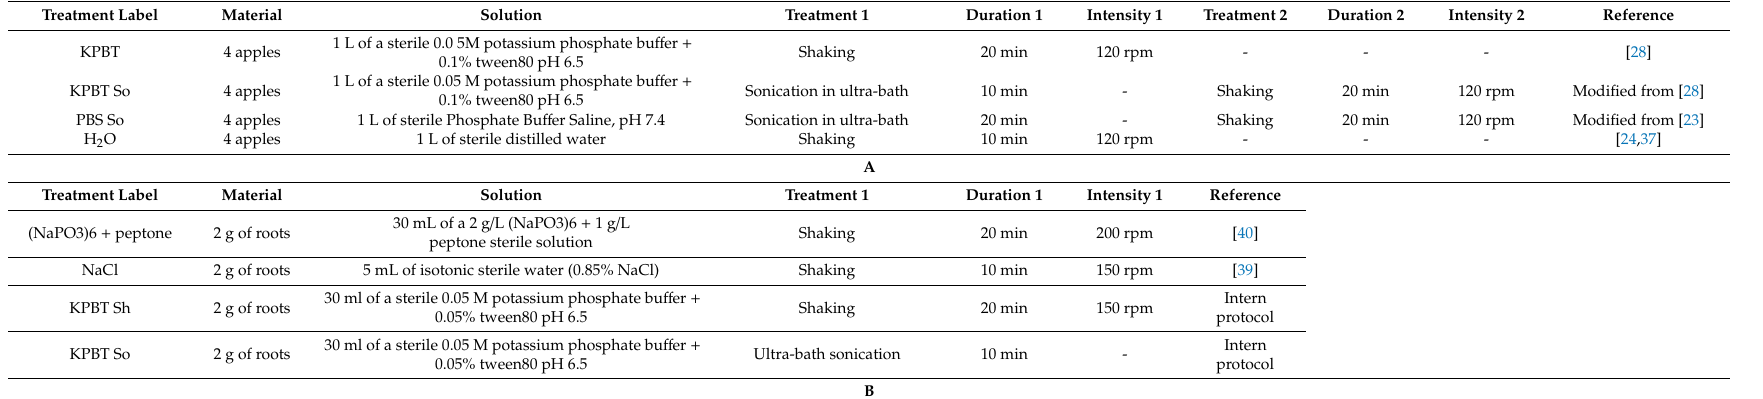
Table 2. Methods description of apple carposphere harvesting (A) and lettuce rhizoplane harvesting (B). Treatment Label